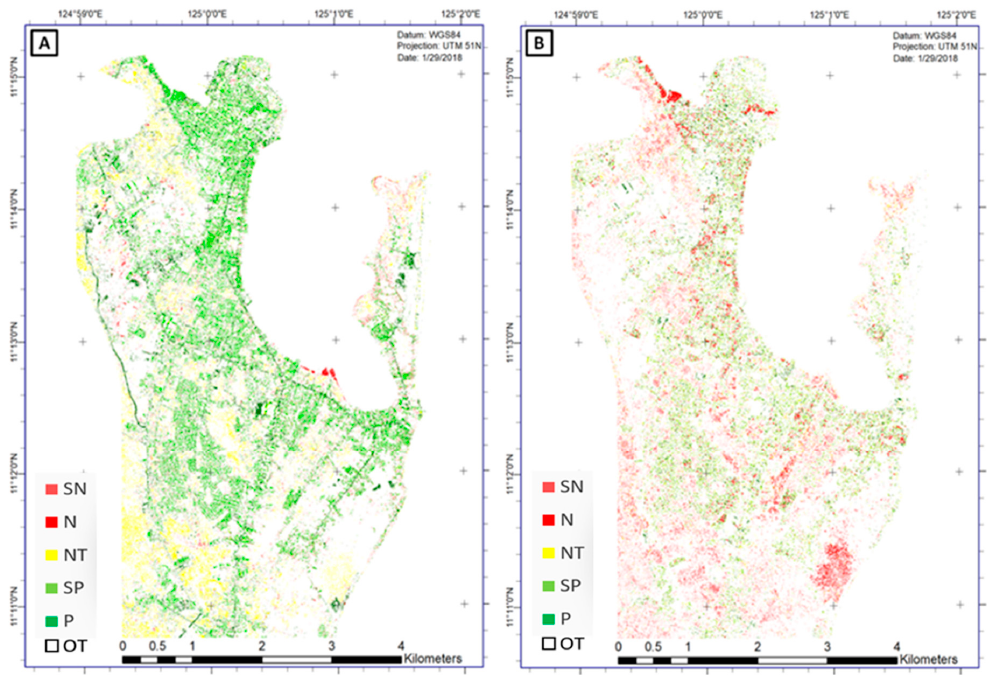
Figure 10. ( A ) LC-based recovery map; ( B ) LU-based recovery map; data source: WorldView-2 images (T0, T1, and T2). Main observation: The striking difference between A and B is mainly due to 2 issues: